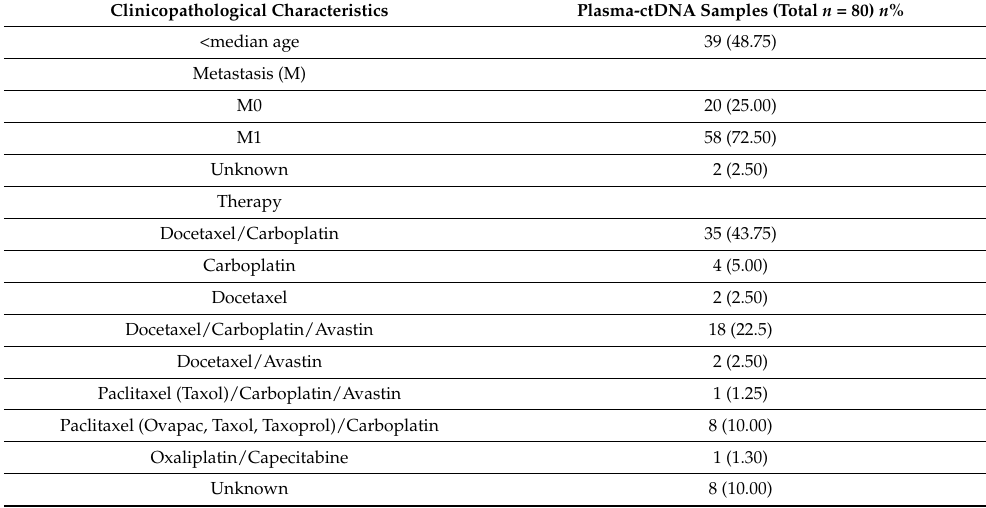
Table 2. Cont. Clinicopathological